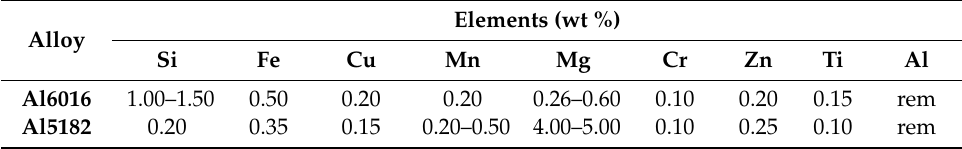
Table 1. Chemical composition of the Al alloys used as substrates